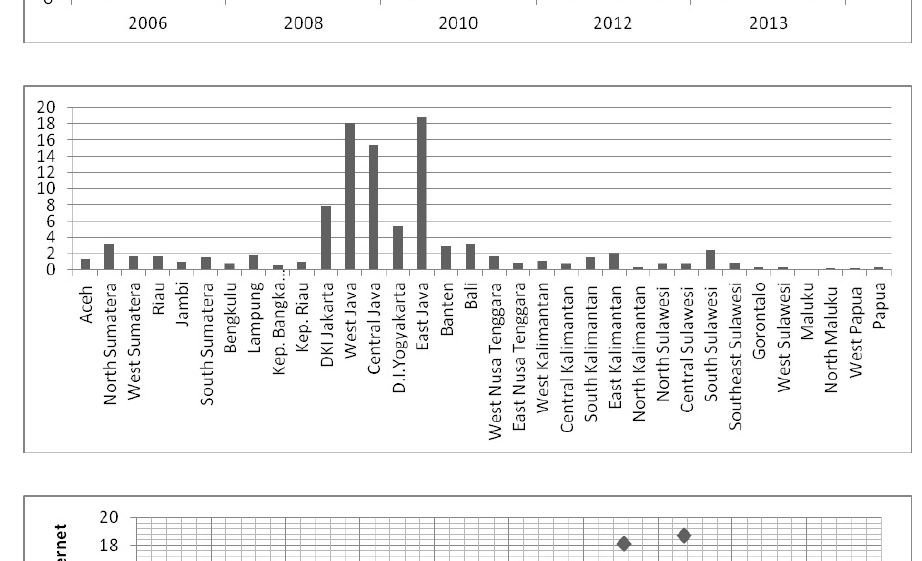
Figure 6. Percentage of MSEs using internet and GDP by